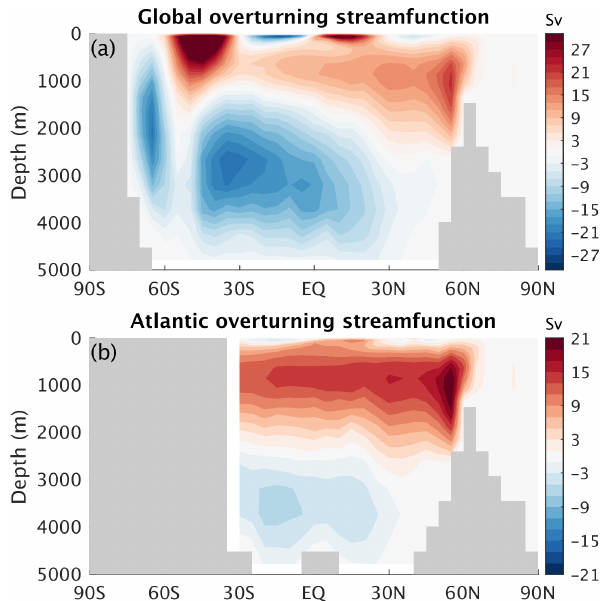
Figure 30. Ocean overturning circulation at the last glacial maxi- mum: (a) global and (b) Atlantic.